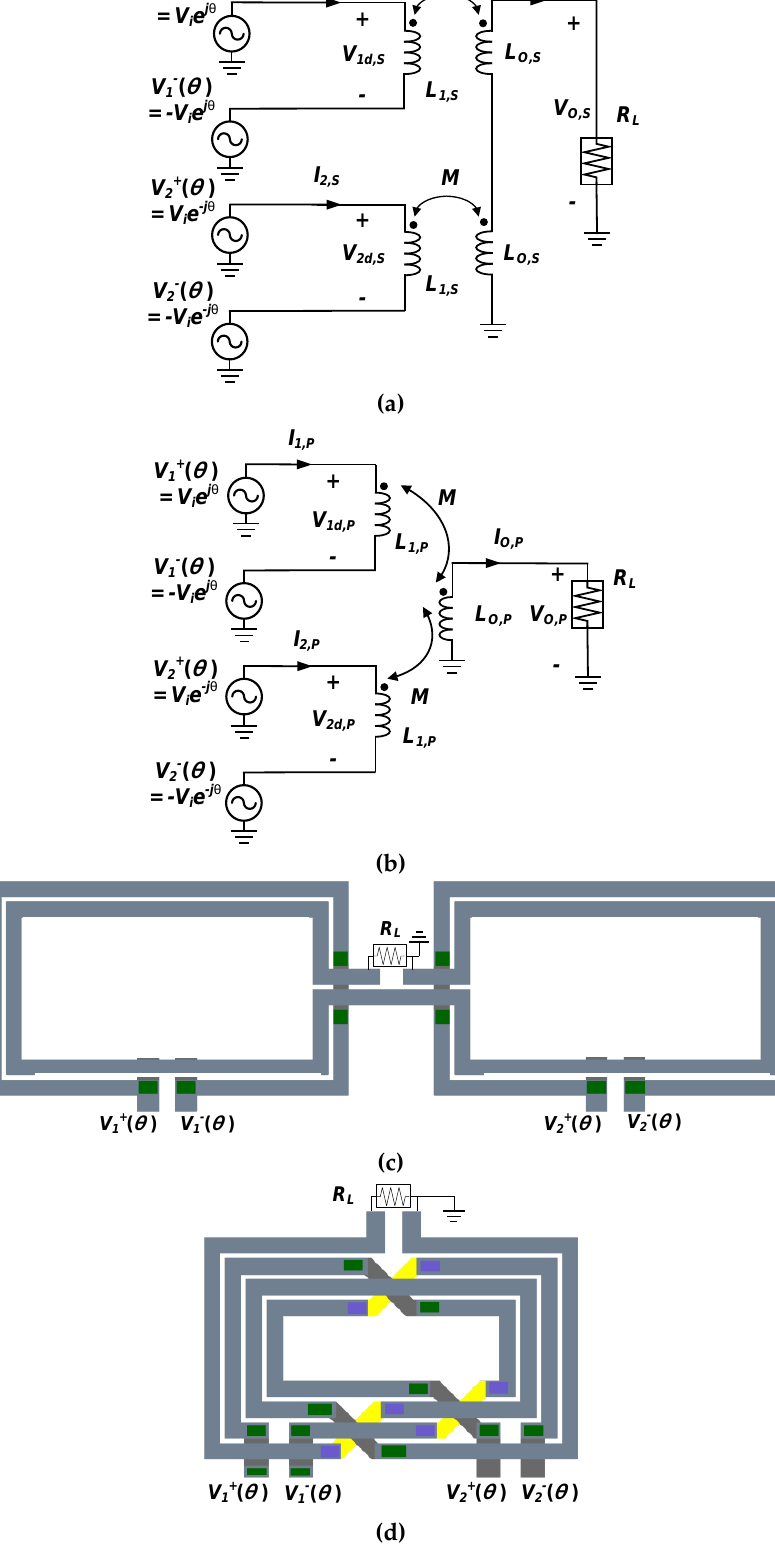
Figure 3. Outphasing operation for series-combining transformer (SCT) and parallel-combining transformer (PCT): ( a ) SCT with non-ideal model; ( b ) PCT with non-ideal model; ( c ) example layout for SCT; ( d ) example layout for PCT.